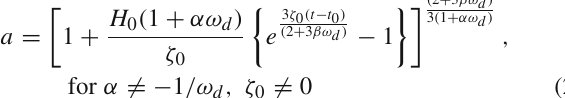
From (24) or (25), we observe that for ζ 0 =